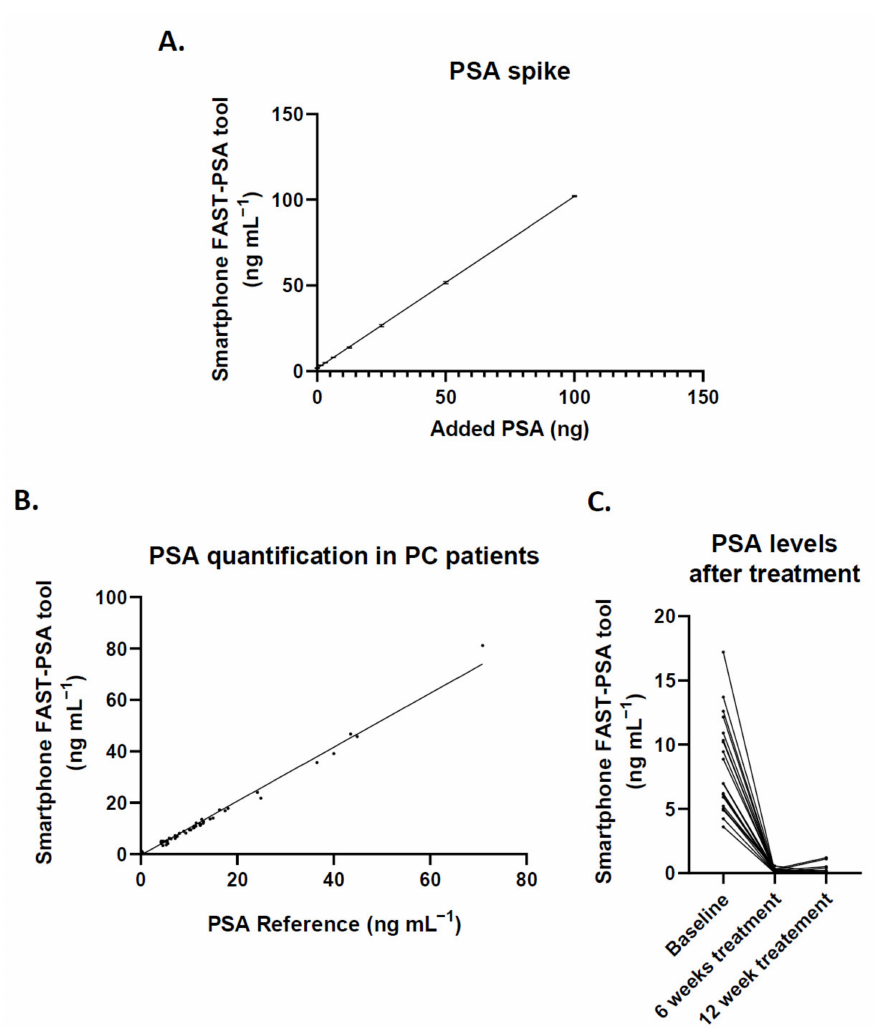
Figure 5. ( A ) The specificity and accuracy of the methodology were determined by spiking serum from healthy donors with known amounts of PSA; this graph depicts the mean of three independent experiments, with an error bar representing the standard deviation (SD). ( B ) Comparison of PSA data between the Smartphone FAST-PSA tool and laboratory testing (RIA or ELISA). Each dot represents the same sample analyzed by both methods. ( C ) Determination of the usefulness of the tool for the follow-up of patients with PCa; the graph depicts PSA levels at baseline (before treatment) and at 6 and 12 weeks of chemical castration